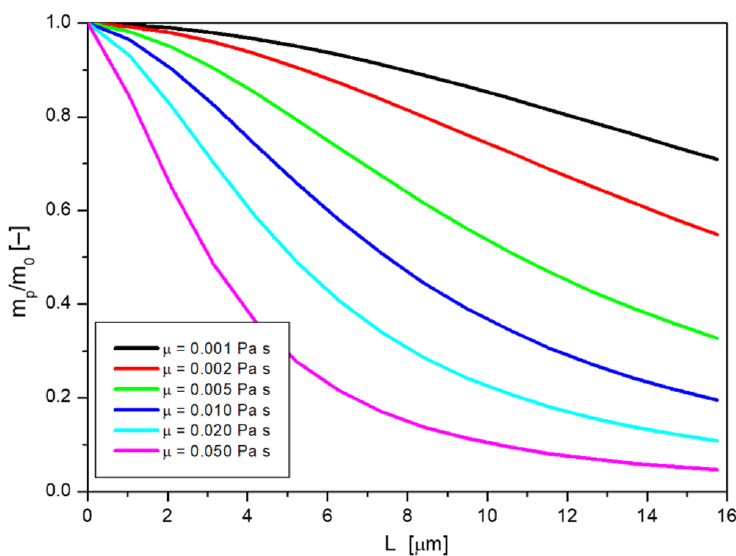
Figure 9. Dependence of dimensionless nanoparticle mass on skin film thickness for the diffusion of liquids with different viscosities.